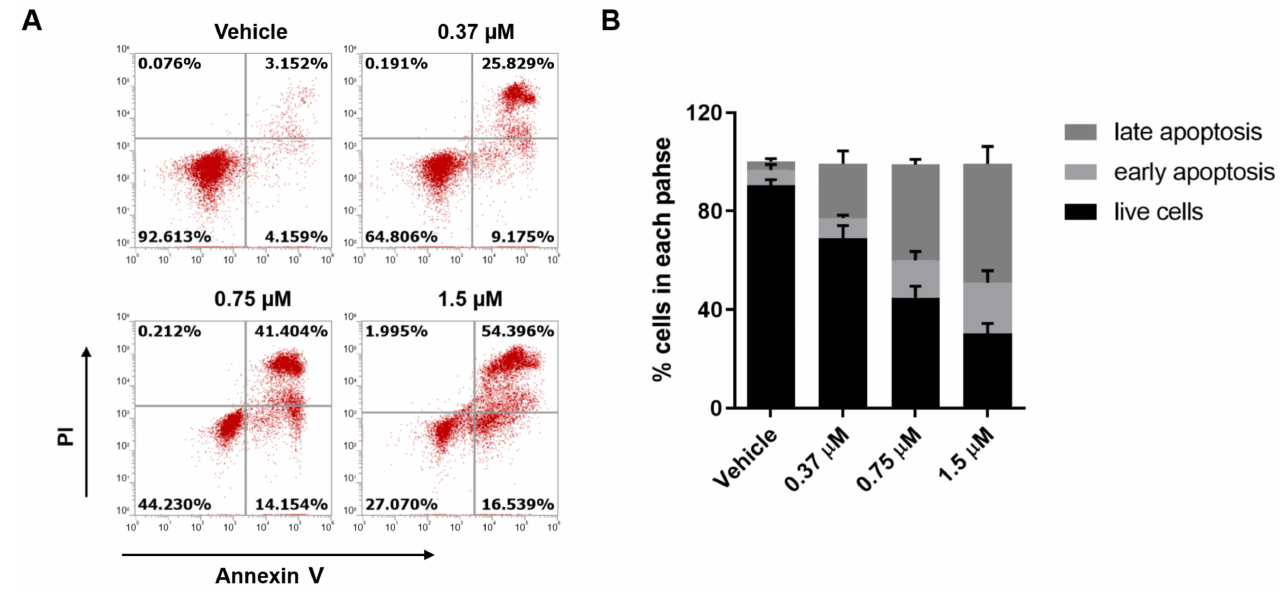
Figure 3. The effect of compound 18 on the apoptosis of MGC-803 cells. ( A , B ) MGC-803 cells were treated with compound 18 at the indicated concentrations for 48 h, which was then analyzed by using Annexin V-FITC/PI double staining through flow